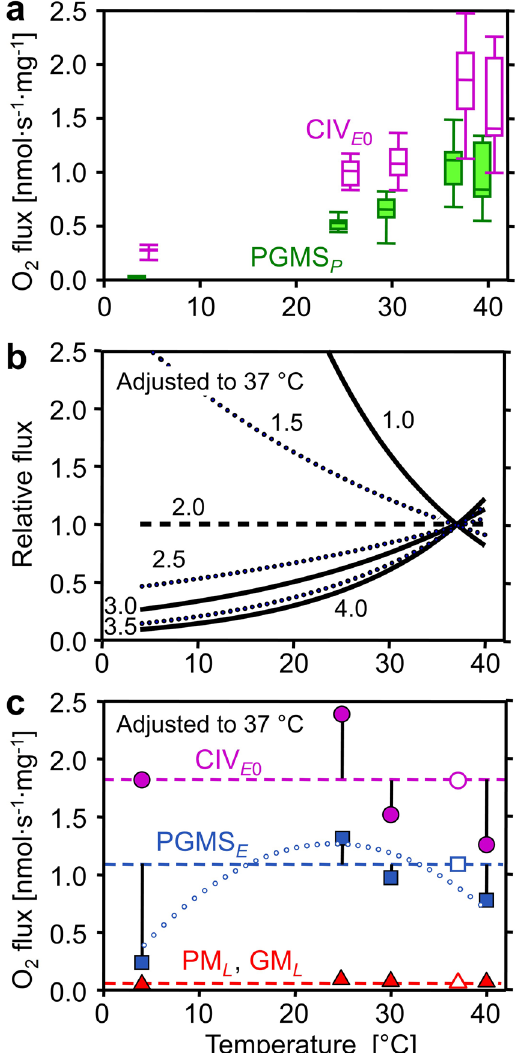
Figure 4. Effect of temperature on mitochondrial respiration. ( a ) Mass-specific oxygen flux ( J O2 ) in respiratory states PGMS P (filled boxes) and CIV E 0 extrapolated from the threshold plots in Fig. 5 (empty boxes). ( b ) Respiratory flux ( j O2 ) relative to a simple temperature reference model: the reference flux is defined at 37 °C as 1.0 and at other temperatures as 1.0 if Q 10 is constant at 2.0 (horizontal dashed line). Non-linear deviations from standard conditions (full and dotted lines) are obtained when Q 10 differs from 2.0 ( Q 10 shown by numbers) and is constant throughout the entire temperature range. ( c ) j O2 relative to standard temperature correction of flux at 37 °C ( Q 10 = 2.0; horizontal lines): CIV E 0 ( ● extrapolated from the threshold plots, Fig. 5), ETS capacity ( ■ PGMS E ), and LEAK respiration ( ▲ pooled GM L and PM L ). Vertical bars show deviations of experimental results (means, n = 5 to 14) from the theoretical line for a Q 10 of 2.0. The dotted trend line illustrates the change of temperature sensitivity for ETS, particularly at 4 °C. For box plots and abbreviations see Figs 1 and